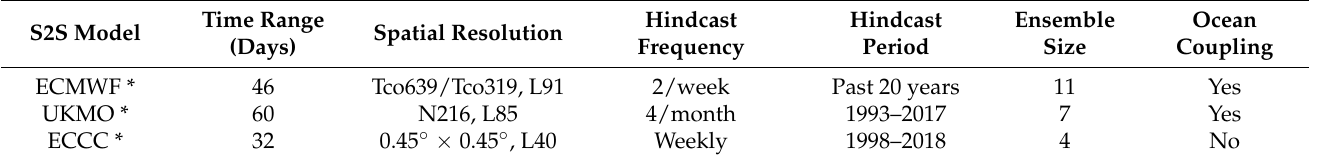
Table 1. Configuration of S2S